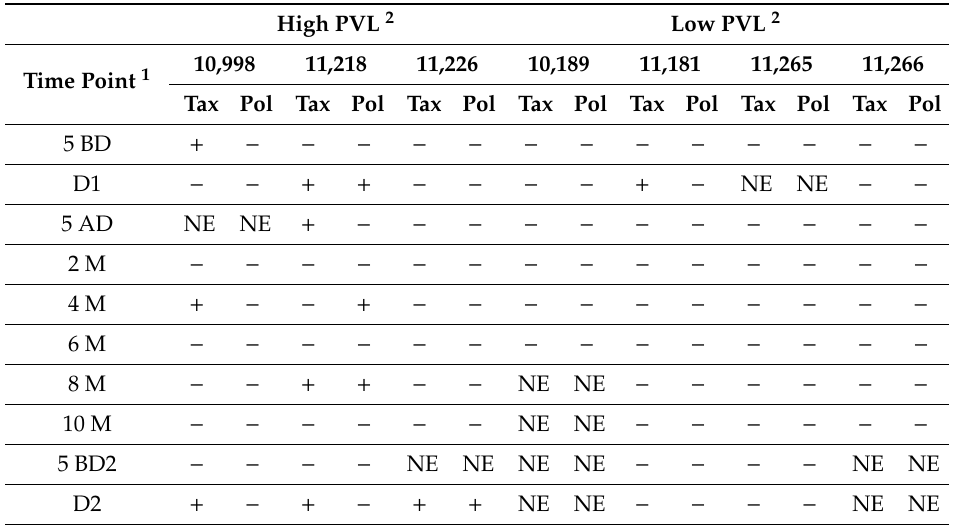
Table 1. BLV (bovine leukemia virus) RNA detection by RT-nested PCR in whole blood samples of naturally infected animals. Tax and pol genes were amplified. ( + : positive; − : Not detected; NE: Not evaluated). All samples were analyzed in